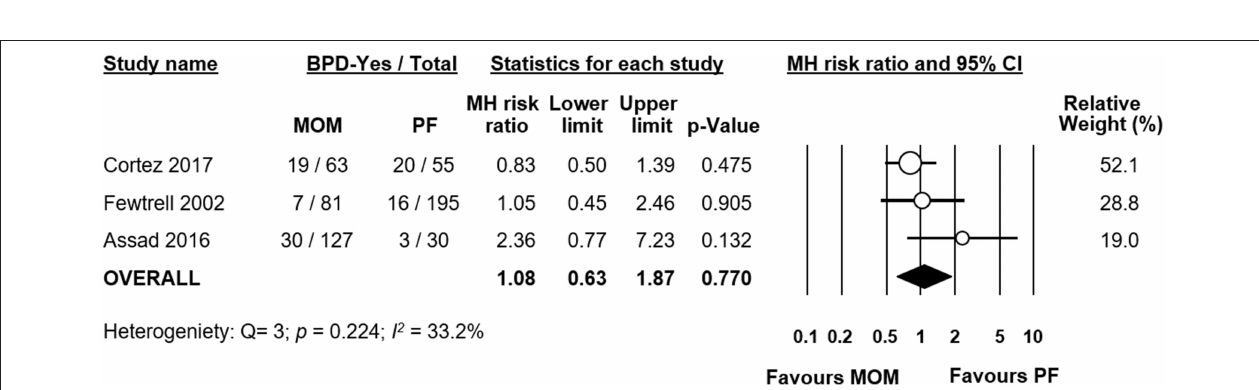
FIGURE 2 | Meta-analysis of exclusive MOM vs. any PF and risk of BPD. MOM, mother’s own milk; PF, preterm formula; BPD, bronchopulmonary dysplasia; CI, confidence interval; MH, Mantel-Haenszel.